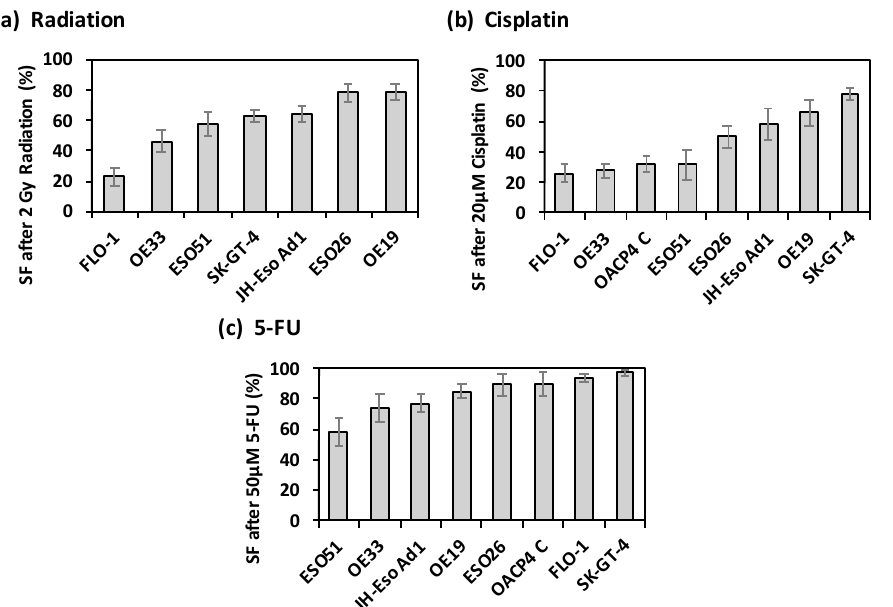
Figure 1. Intrinsic radiation and chemotherapy drug resistance of OAC cell lines. ( a ) Survival Fraction ± SD of OAC cell lines measured via clonogenic assay after irradiation with 2 Gy, normalised to negative controls, and assessed in n = 3 independent experiments; ( b ) Resistance of OAC cell lines after 20 µM Cisplatin treatment, and ( c ) after 50 µM 5-FU treatment, compared to vehicle controls, mean ± SD survival fraction measured via apoptosis assay, and assessed in n = 3 independent experiments.